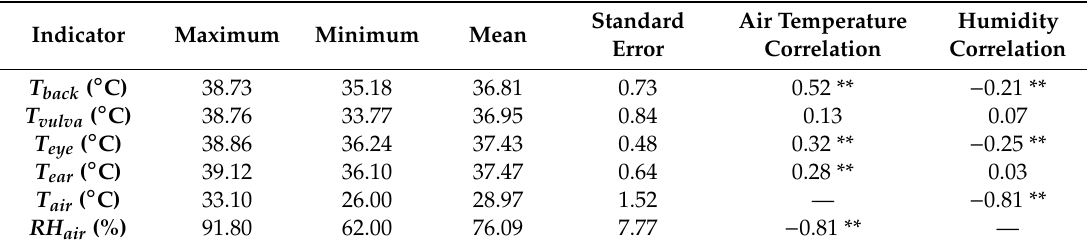
Table 1. Swine ROI temperature statistical characteristics and correlation with environmental factors.